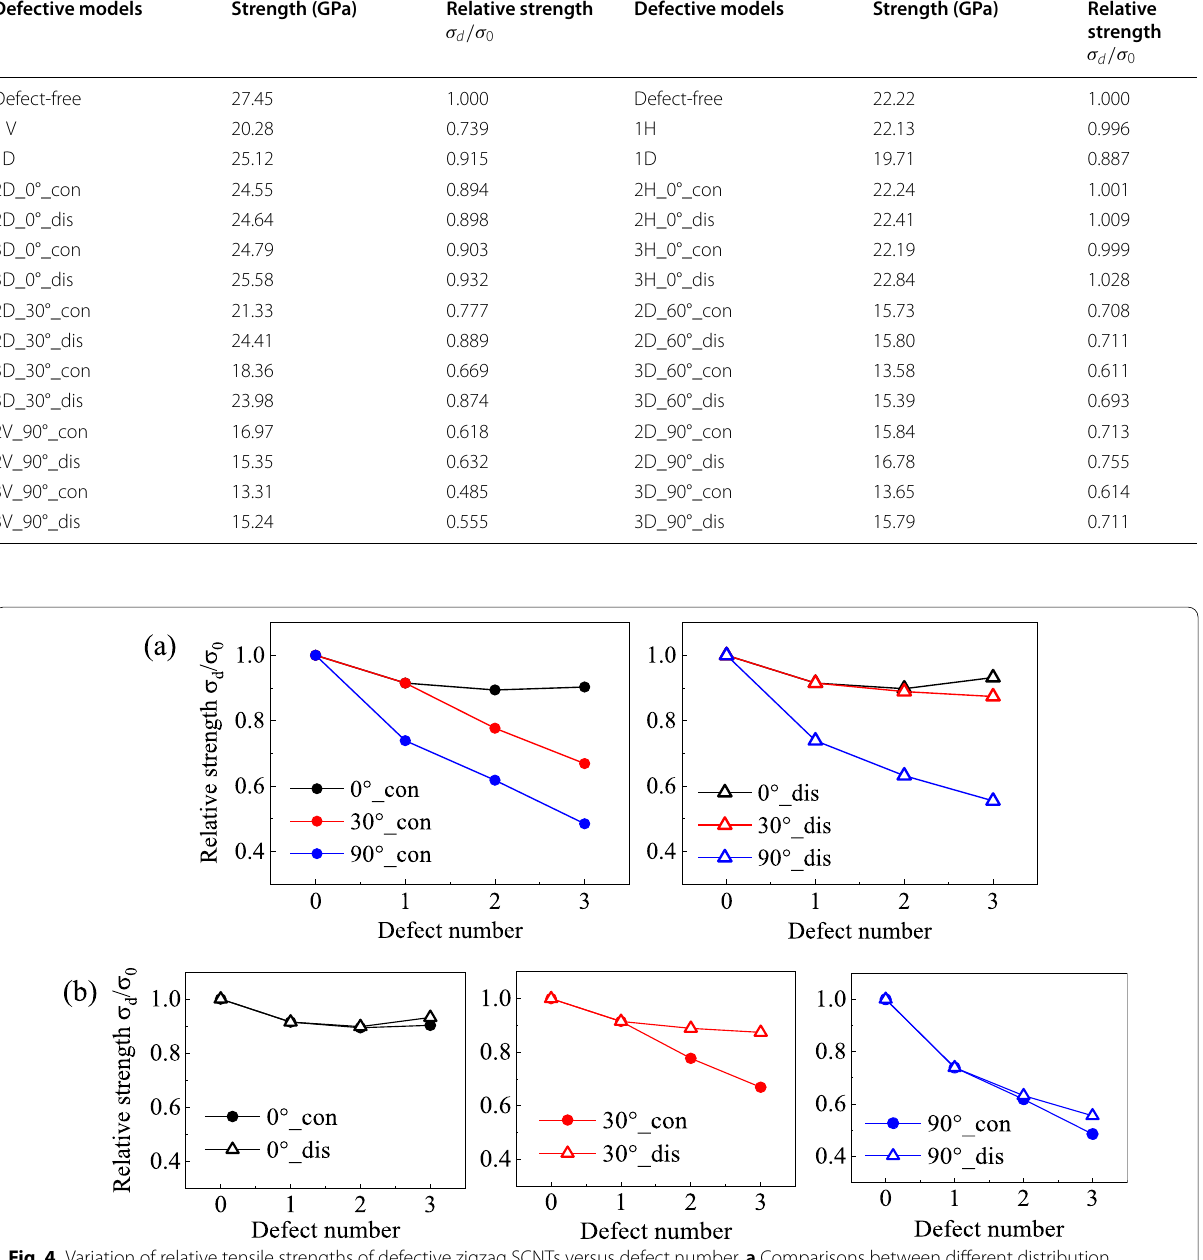
Table 1 Tensile strengths and relative tensile strengths of defective zigzag and armchair SCNTs Zigzag SCNTs Armchair SCNTs